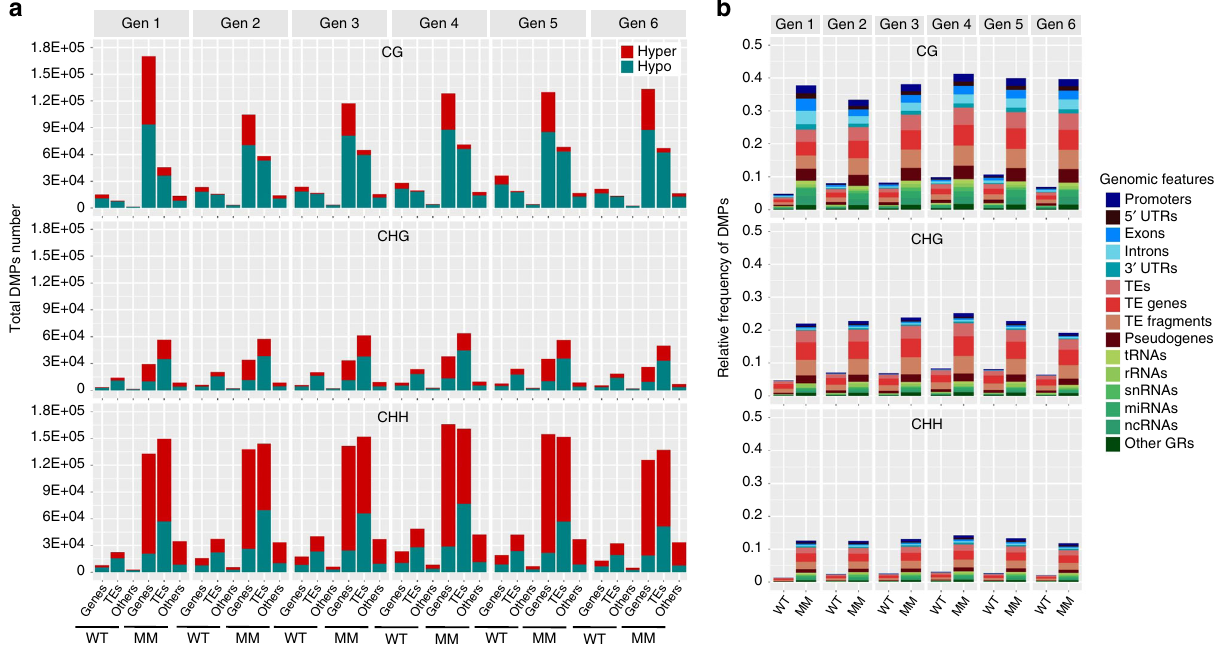
Fig. 3 DMP counts and genomic distribution in msh1 memory line. a Total hyper- and hypomethylation DMP counts in CG, CHG, CHH context embedded in genic regions (gene coding plus 1 kb upstream to start codon, 1 kb downstream to stop codon), TE-related regions (including TEs, TE genes, TE fragments and pseudogenes) and others (including tRNAs, rRNAs, snRNAs, miRNAs, ncRNAs). DMPs were de fi ned as hyper if the site methylation difference in comparisons of each individual to the average of reference plants (the centroid of the wild type group) is greater than 0 and de fi ned as hypo if less than 0. b The relative frequency of DMPs in genic regions (blue shades), TE-related regions (in red shades) and others (in green shades). The average of fi ve wild- type plants (the centroid of the wild-type group) was used as a reference for each generation. The relative frequency of DMPs in each genomic feature was estimated as the number of DMPs divided by the number of total genomic cytosine positions in each genomic feature. Each individual ’ s DMP number and frequency is computed separately and the group mean for WT (wild type) and MM ( msh1 memory) are presented. Notice that DMPs are detected within wild-type samples due to spontaneous variation, distinct from treatment-induced, is detectable within our system. Source data underlying Fig. 3a, b are provided as a Source Data fi